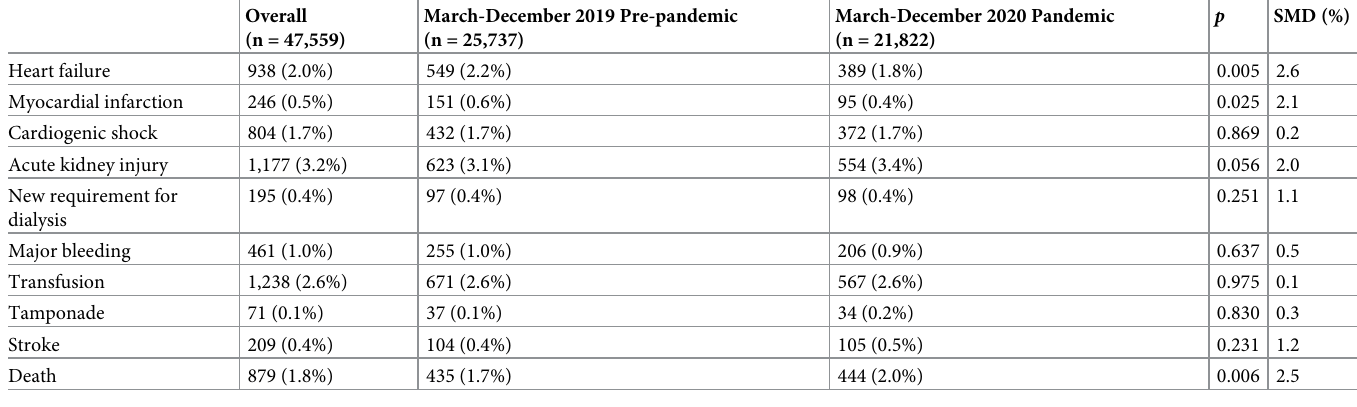
Table 2. In-hospital outcomes in the overall